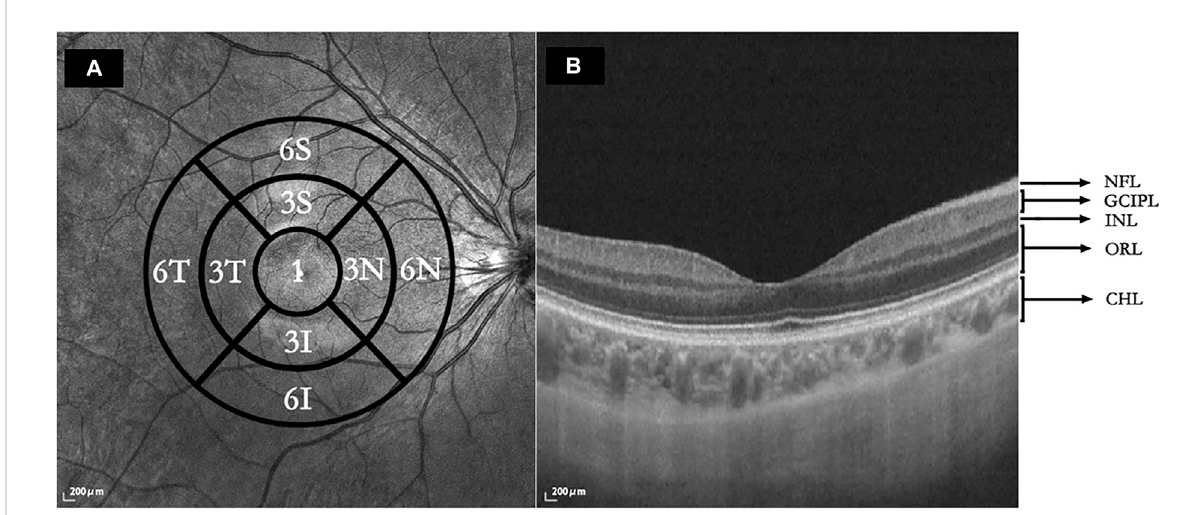
FIGURE 1 (A) Macular regions according to the Early Treatment of Diabetic Retinopathy Study. 1: central foveal circle; 3: parafoveal circle; 6: perifoveal circle; T: temporal; N: nasal; S: superior; I: inferior. (B) Segmentation of fi ve intraretinal layers and choroidal layer. Using SS-OCT/OCTA, the cross- sectional image was centered on the fovea retina during the horizontal scan and segmentation of the intraretinal and choroidal layers was performed. NFL: nerve fi ber layer; GCIPL: ganglion cell layer and inner plexiform layer; INL: inner nuclear layer; ORL: outer plexiform layer and outer nuclear layer and photoreceptor layer and retinal pigment epithelium (RPE)/Bruch ’ s membrane complex layer; CHL: choroid